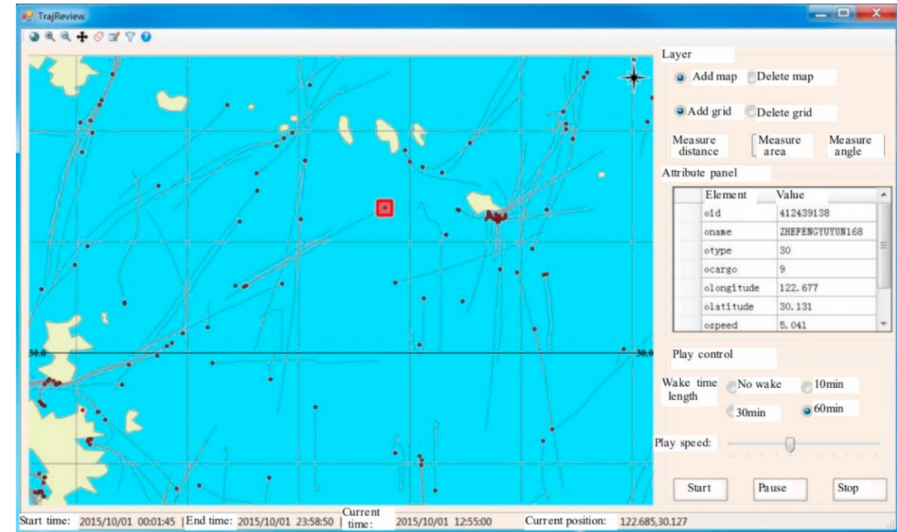
Figure 16. STDMAS historical trajectory review interface.